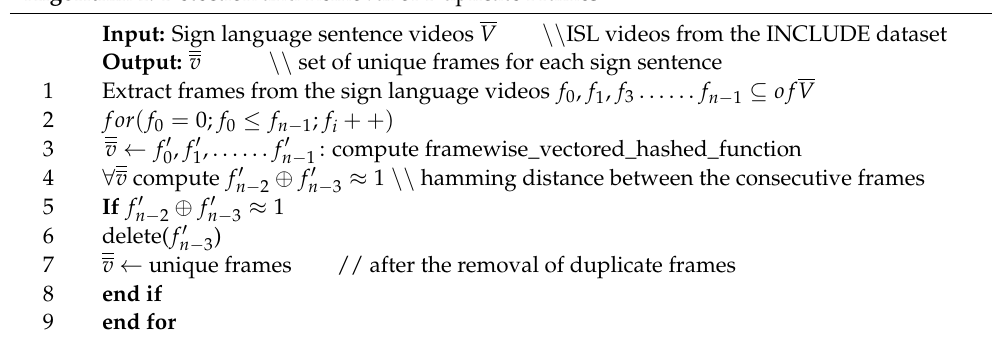
Algorithm 1: Detection and Removal of Duplicate